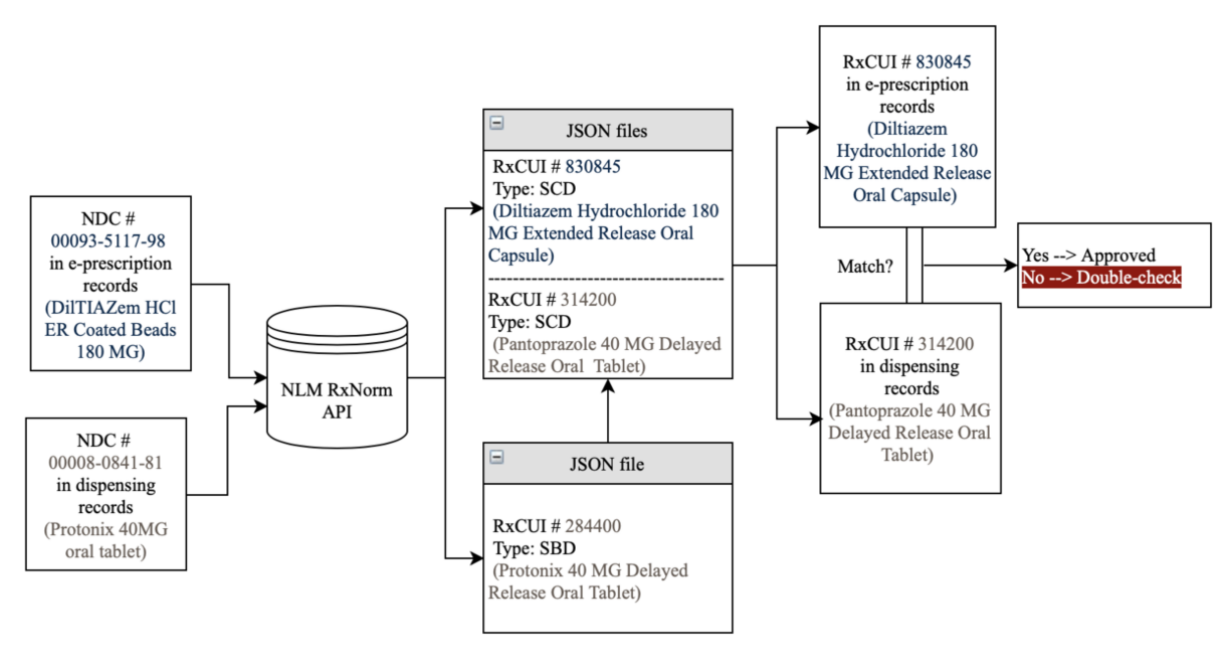
Figure 2. Proposed system for detecting medication selection errors of e-prescriptions with RxNorm application programming interface. A